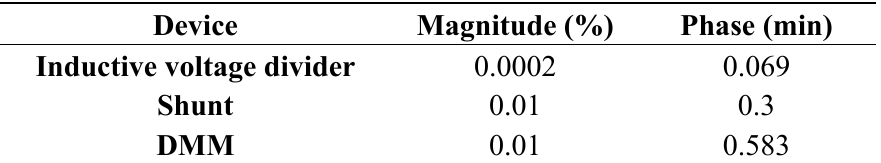
Table 1. Uncertainties of the standard